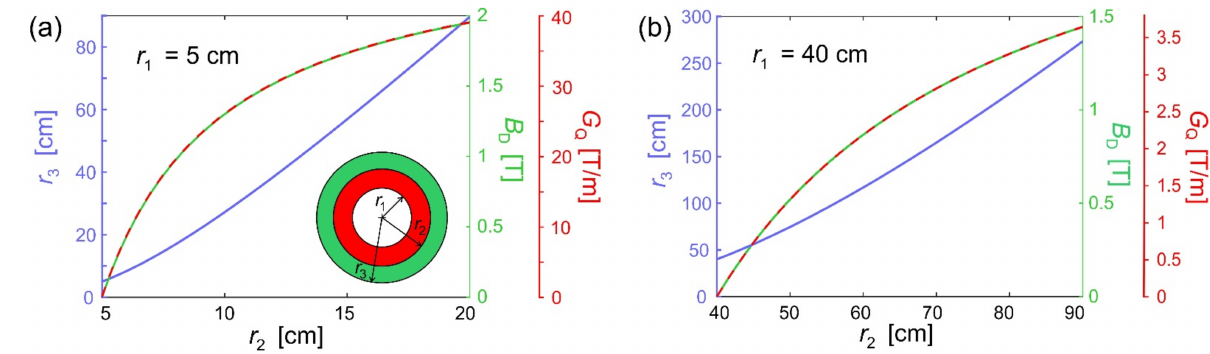
Figure 4. Estimation of the achievable magnetic fields and gradient strengths for a simple guiding system consisting of an inner Halbach-quadrupole (red) and an outer Halbach-dipole (green) (see sketch of the geometry inserted in ( a )). Shown is the dependence of the homogeneous field, B D (green line), produced by the dipole and the gradient, G Q (dashed red line), of the quadrupole versus the inner radius of the dipole r 2 . Both have the same functional dependence but scale with r 1 . Therefore, there are two axes on the left in the respective colors. In ( a ), the internal radius is set to r 1 = 5 cm, which could allow for guiding objects inside a rodent. The innermost radius in ( b ) of r 1 = 40 cm was chosen to host a human. A remanence B R = 1.3 T was used in both cases. The outermost radius, r 3 , B D , and G Q are then given by Equation (15).